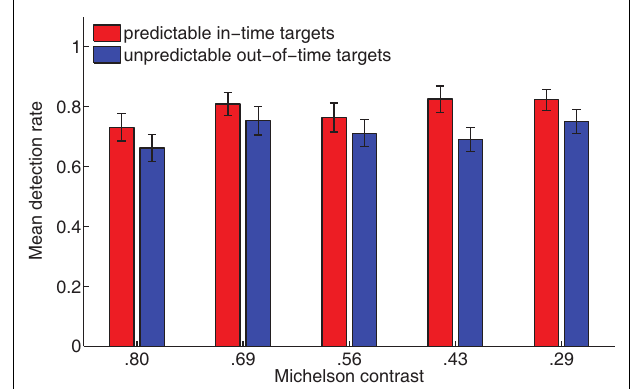
FIGURE 2 | Results of the pre-test. Here, subjects performed the task without saccading, with a fixation cross at the center and the apparent motion display at an eccentricity of 7˚ to the right. Contrast between background and stimuli was varied in five steps to determine the optimal stimulus contrast for each subject individually. Replicating previous results (Schwiedrzik et al., 2007), mean detection rates were higher for in-time targets than for out-of-time targets ( p < 0.001). Error bars indicate 1